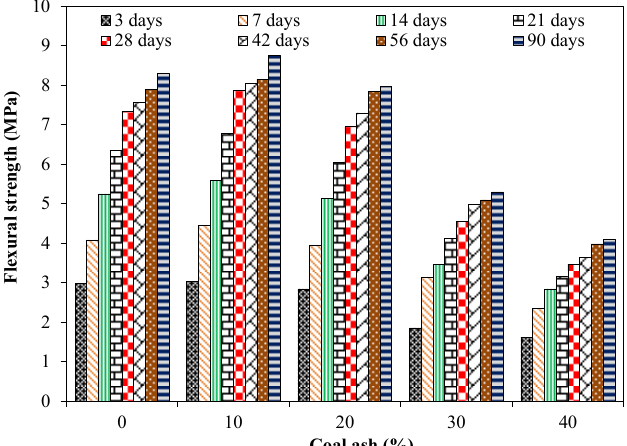
Figure 8. Results of flexural strength for specimens incorporating CA placed in normal water.